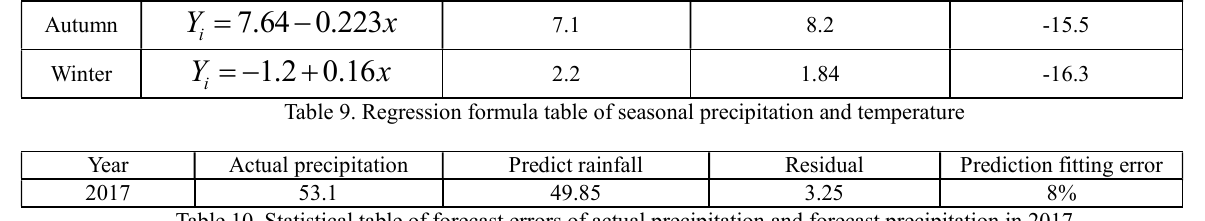
Table 10. Statistical table of forecast errors of actual precipitation and forecast precipitation in 2017